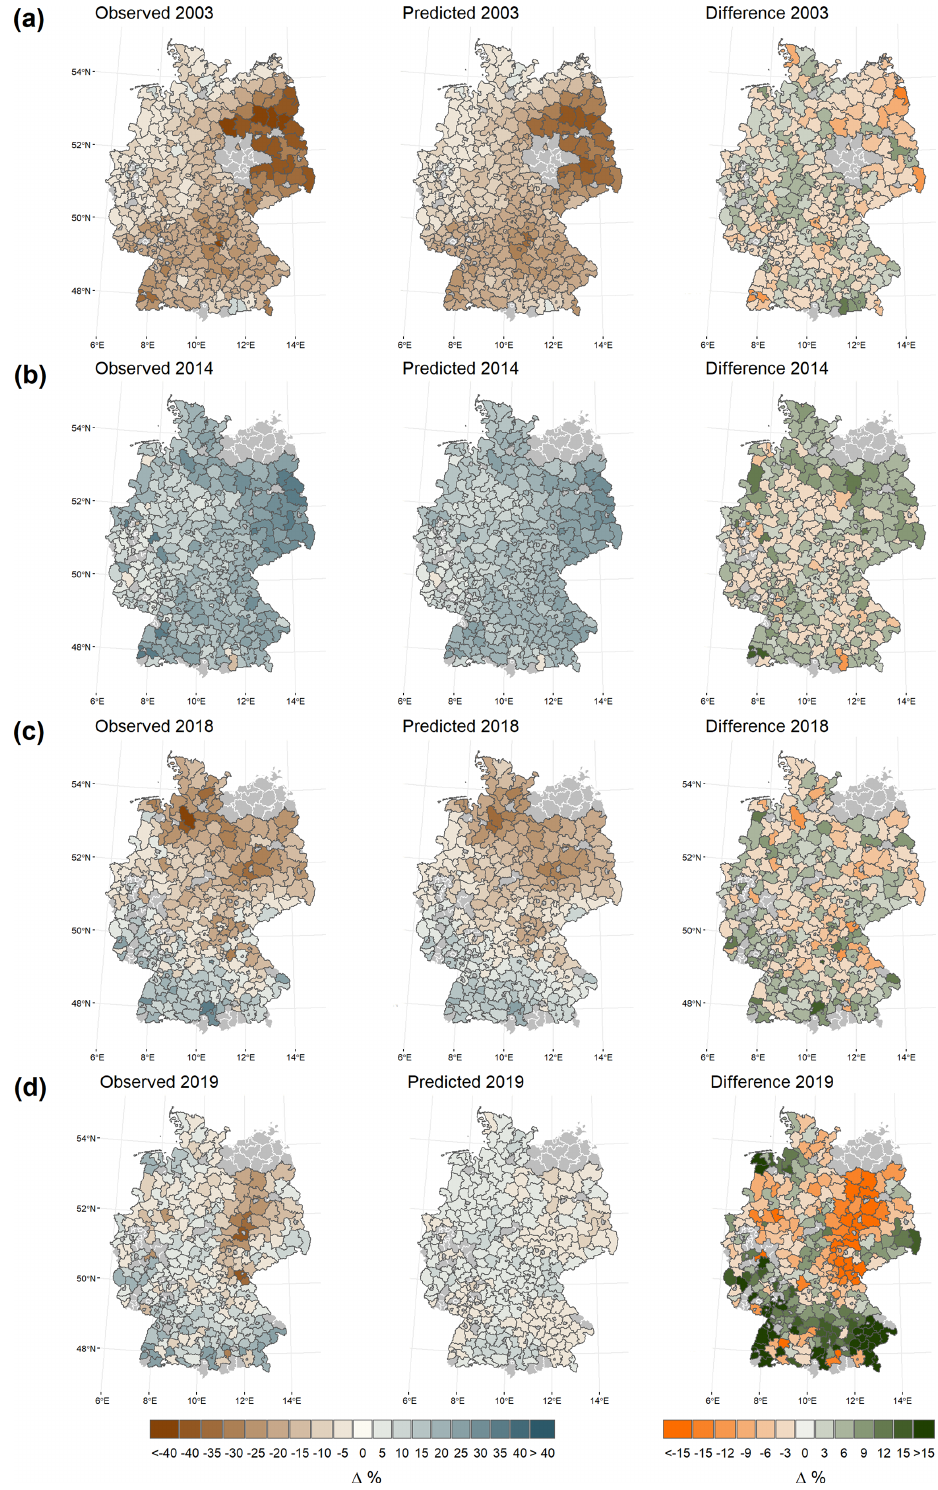
Figure 5. Maps of the observed, the predicted (for PAM clustering with four sub-regions), and the difference between these two for winter wheat yield anomalies for the in-sample years 2003 (a) , 2014 (b) , and 2018 (c) as well as 2019 (d) , for which the model was not trained, at the district level. Administrative districts with missing data are displayed in